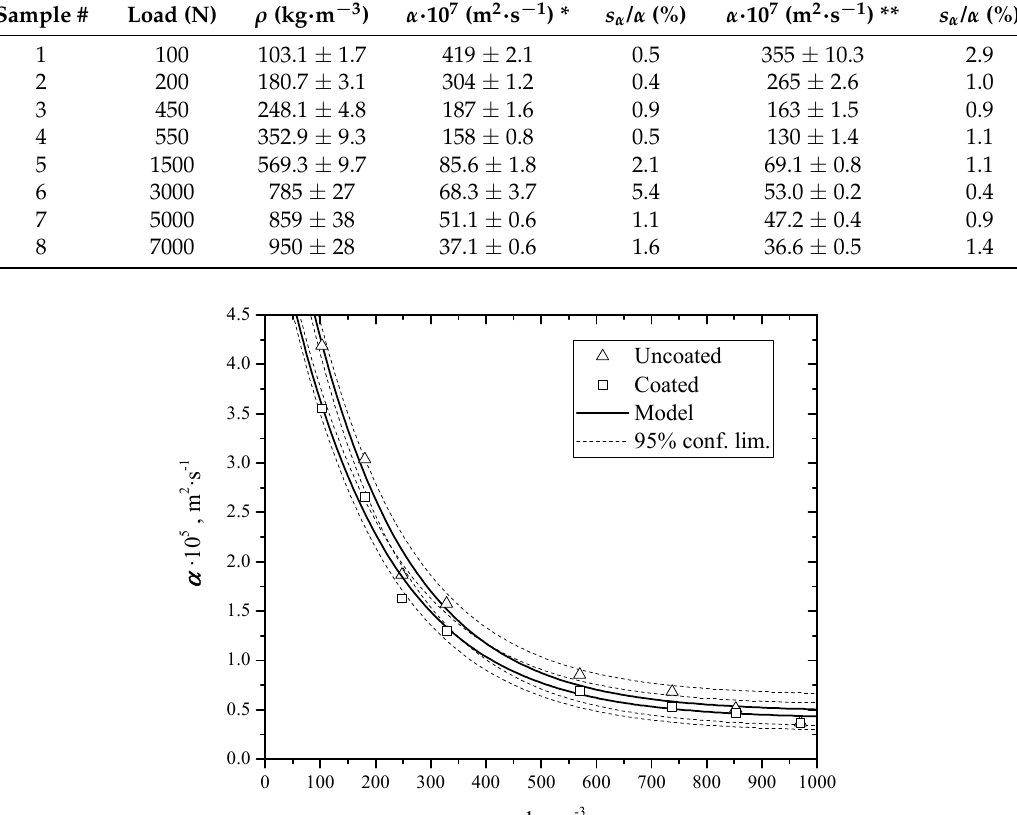
Figure 8 . Overlapped trends of α values of the colloidal graphite coated samples and uncoated, as a function of density.